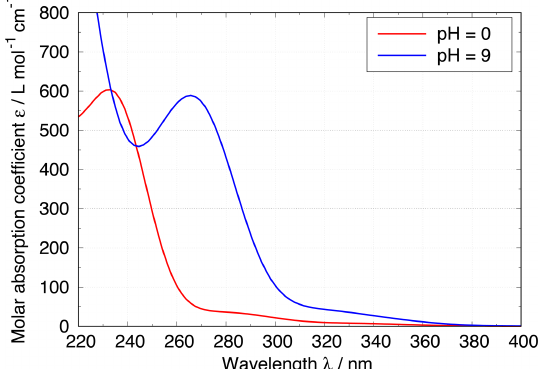
Figure 12. Measured UV absorption coefficient spectra of pyruvic acid in water under acidic (pH = 0; red line) and alkaline (pH = 9; blue line)